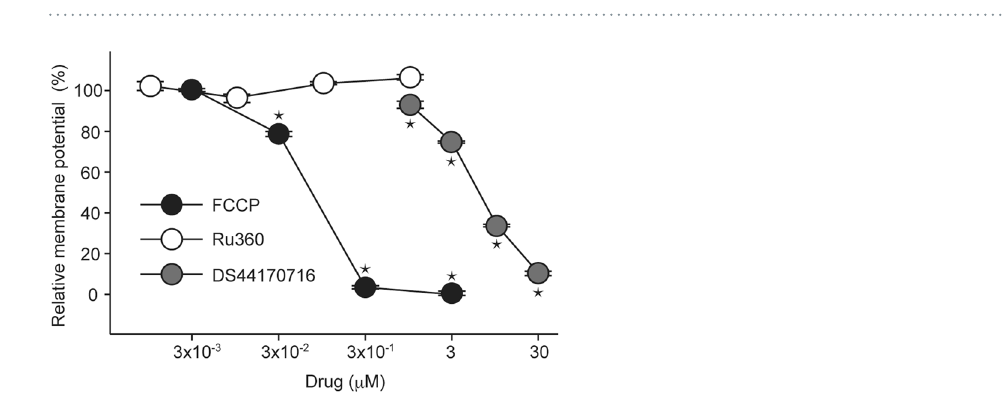
Figure 4. DS44170716 inhibits serum-induced mitochondrial Ca 2 + influx in human HEK293A cells. ( a ) Representative temporal profiles of FCCP effect on serum-induced mitochondrial Ca 2 + influx in human HEK 293 A cells. ( b ) FCCP effect on serum-induced mitochondrial Ca 2 + influx in human HEK 293 A cells. The data shown were total mitochondrial Ca 2 + influx from 0 to 17 seconds after the serum treatment. ( c ) Inhibitory effect of FCCP on serum-induced mitochondrial Ca 2 + influx in human HEK 293 A cells. ( d ) Representative temporal profiles of DS44170716 effect on serum-induced mitochondrial Ca 2 + influx in human HEK 293 A cells. ( e ) DS44170716 effect on serum-induced mitochondrial Ca 2 + influx in human HEK 293 A cells. ( f ) Inhibitory effect of DS44170716 on serum-induced mitochondrial Ca 2 + influx in human HEK 293 A cells. Data obtained from 3 independent samples are shown as the mean with SEM. Asterisk shows P < 0.05 compared to vehicle group (Dunnett’s test).